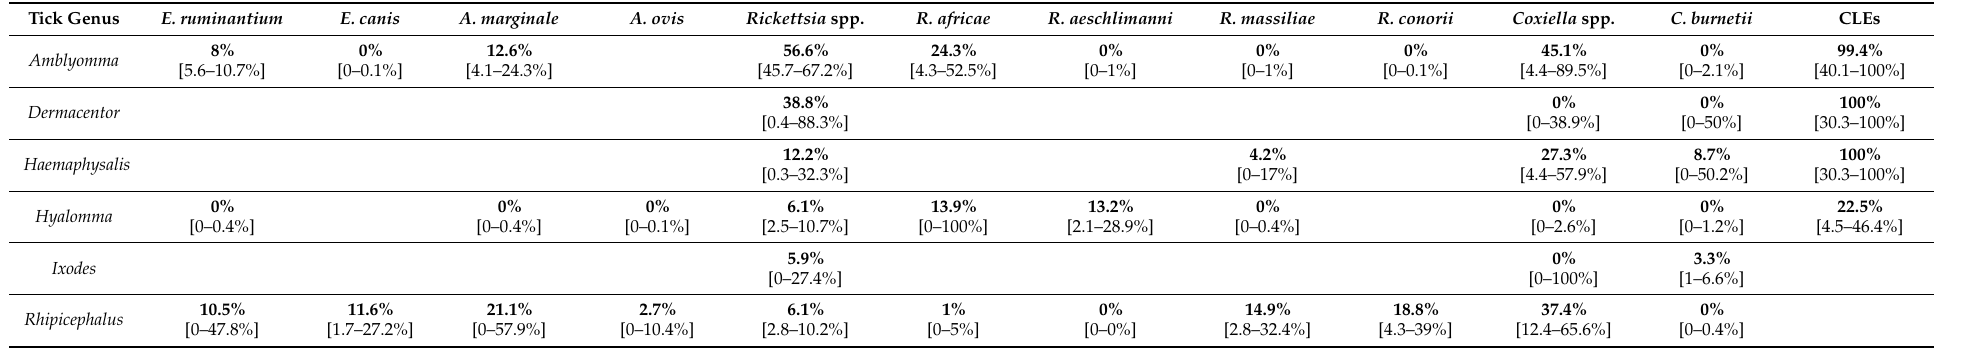
Table 4. Estimated pooled prevalence in different tick